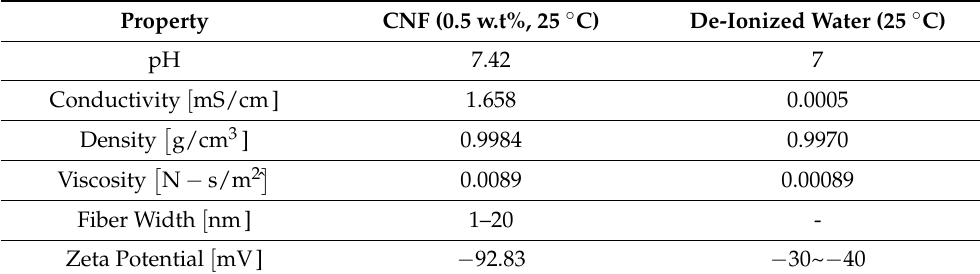
Table 1. Properties of the 0.5 wt% cellulose nanofiber (CNF) fluid and de-ionized water.